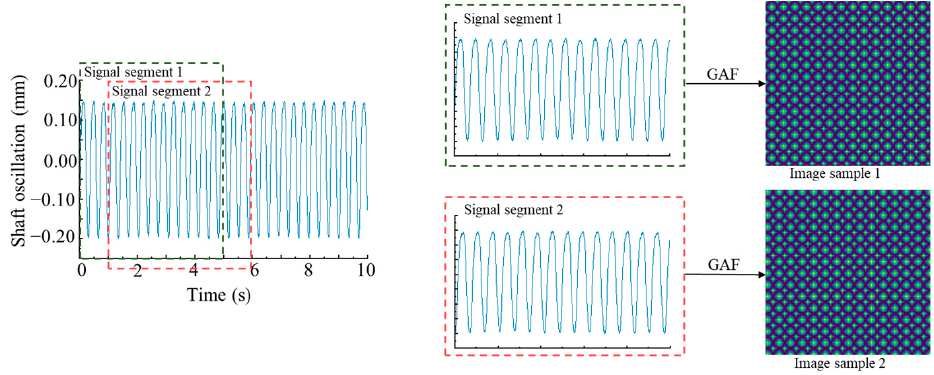
Figure 4. An example of data segmentation.